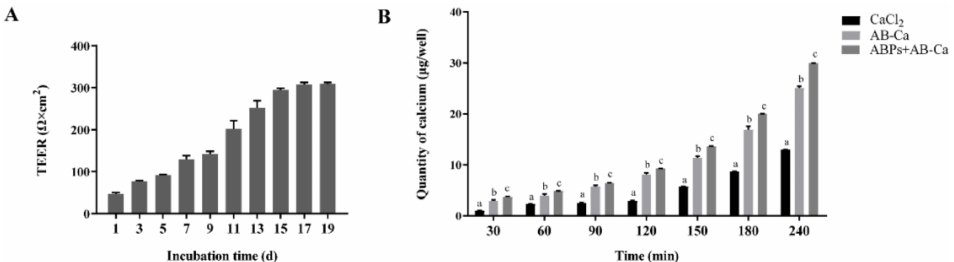
Figure 4. Calcium transport in intestinal Caco-2 cell was considerably enhanced by ABPs. ( A ) The TEER values of the Caco-2 cell monolayers in different days. ( B ) Calcium transport of CaCl 2 , AB − Ca, and ABPs + AB − Ca through intestinal Caco-2 cell monolayers. The columns labeled with different letters (a, b, and c) at a given point in time are significantly different ( p < 0.05), while the same letters are not ( p >